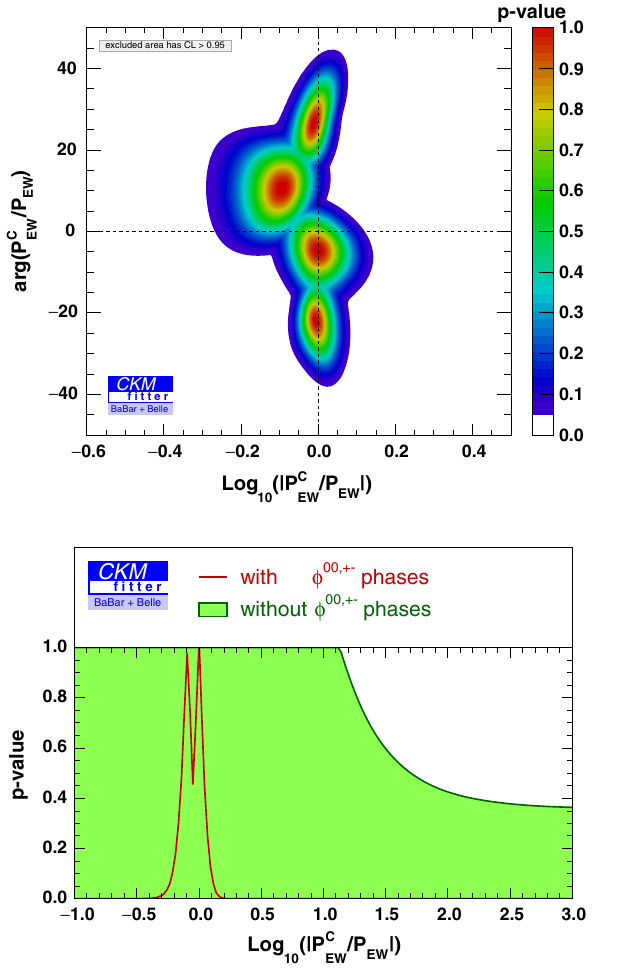
Fig. 10 Top two-dimensional constraint on the modulus and phase / P of the P C (cid:4)(cid:17) (cid:17) (cid:17)(cid:5) EW ratio. Bottom one-dimensional constraint on EW (cid:17) P C / P Log 10 ,usingthecompletesetofexperimentalinputs( red EW EW curve ), and removing the BaBar measurement of the ϕ 00 , +− phases from the B 0 → K + π + π 0 Dalitz-plot analysis ( green shaded curve )